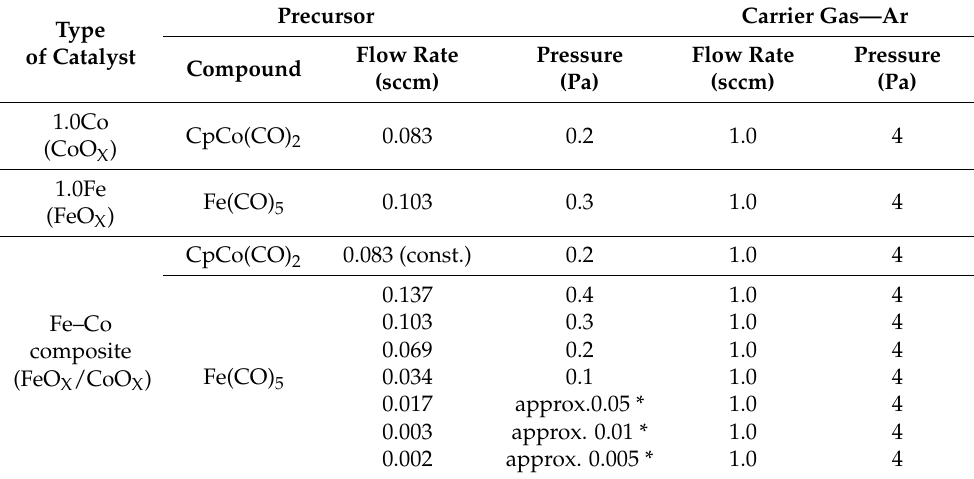
Table 2. Preparation conditions of the thin-film catalysts on the structured support. The